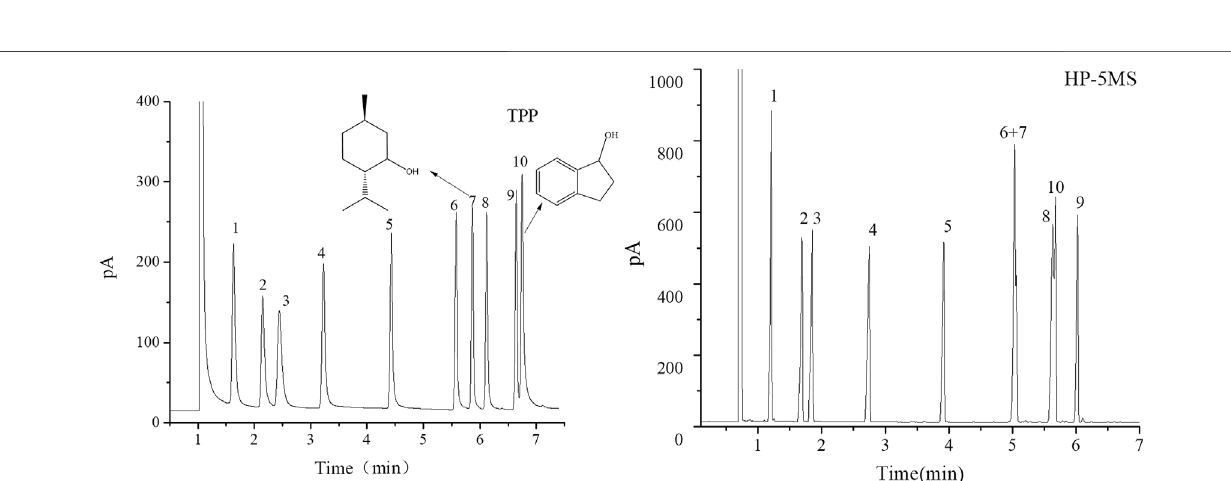
FIGURE 6 | GC separation of the alcohols mixture on the TPP column and HP-5MS column. Peaks: (1) cyclopentanol, (2) n-hexanol, (3) cyclohexanol, (4) n-heptanol, (5) n-octanol, (6) n-nonanol, (7) D/L-menthol, (8) nerol, (9) n-decanol, (10) 1-indanol. Temperature program: 70 ° C (1 min) to 160 C at 15 ° C min − 1 .